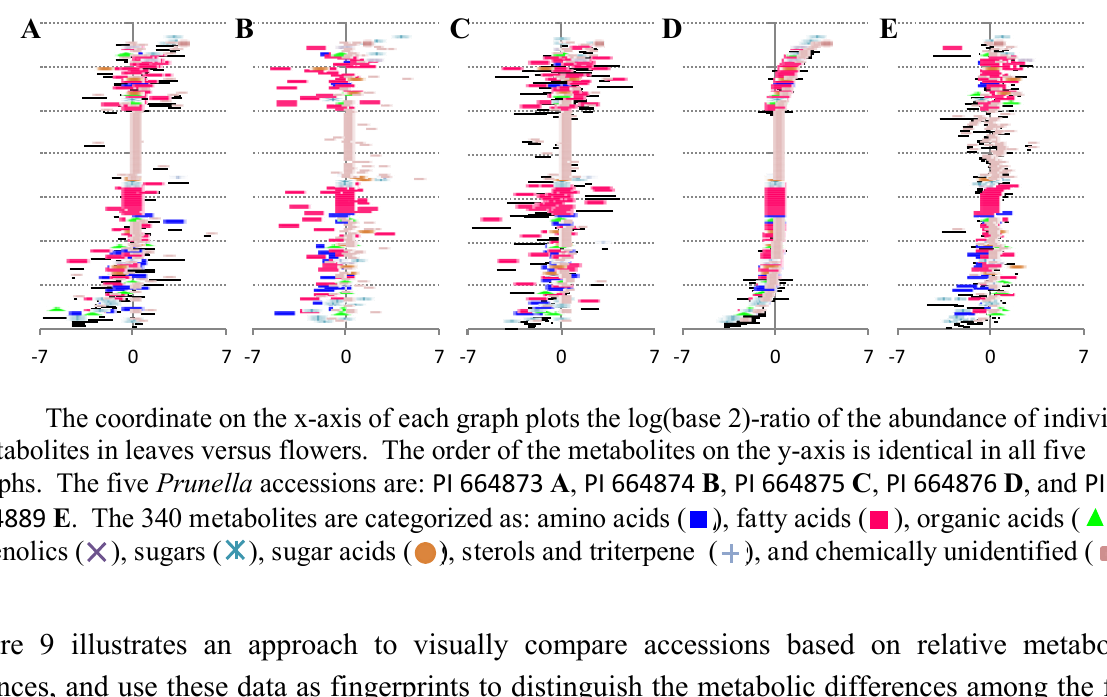
Figure 8. Differential accumulation of 340 metabolites between leaves and flowers among five different Prunella